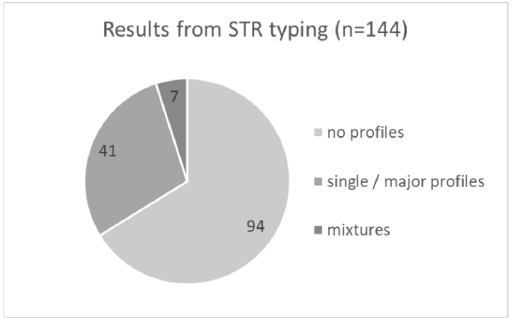
Figure 2. The STR typing results for all 144 crime scene samples summarized. The category “no profiles” includes all profiles not fulfilling the CODIS entry criteria.